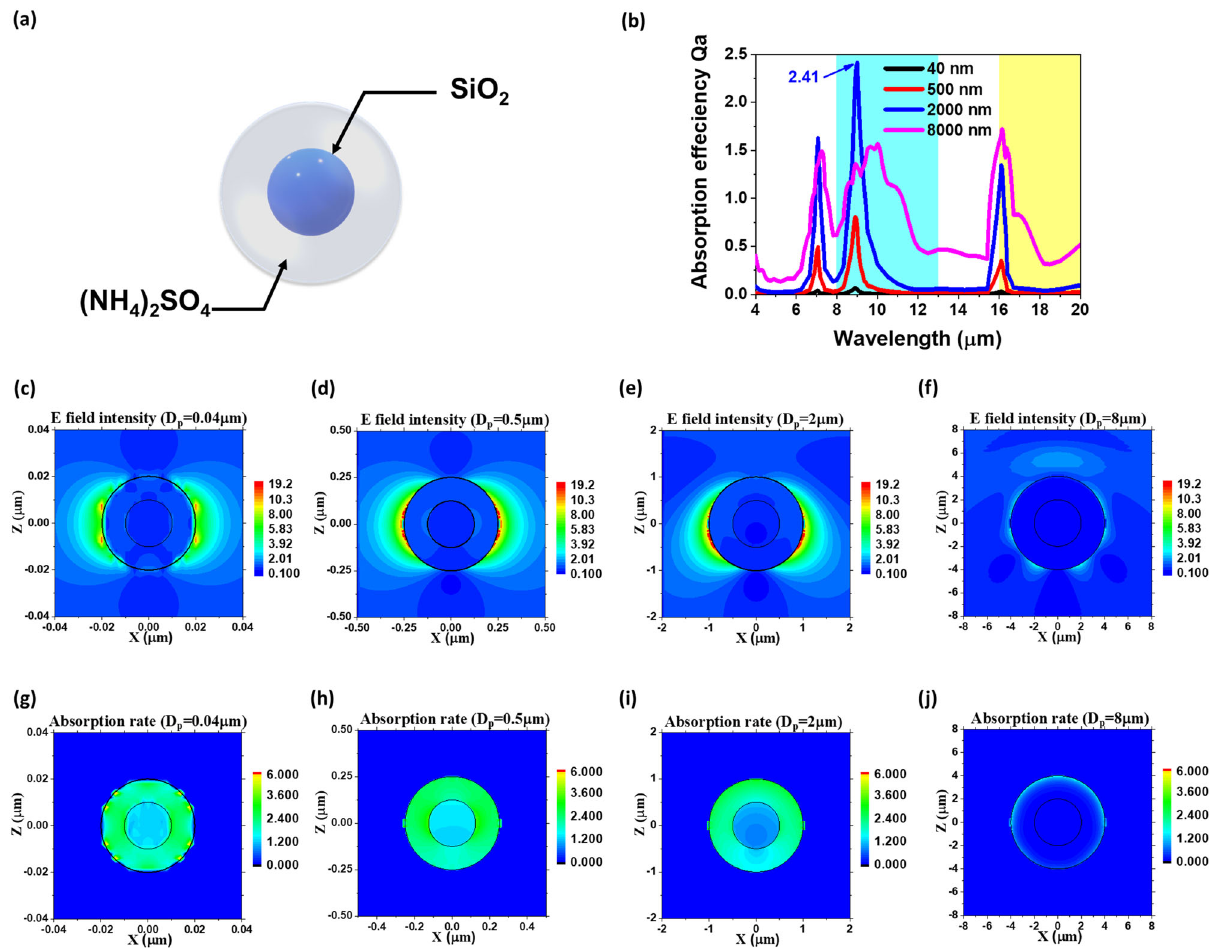
Fig. 3 The Q a spectra and simulated E- fi eld intensities and absorption rates of 0.04, 0.5, 2, and 8 µ m core/shell structure particles. a Schematic representation of the core/shell structure, with SiO 2 as the core surrounded by a concentric spherical shell of (NH 4 ) 2 SO 4 . Here, the core/shell ratio is set at 0.5. b Q a spectra of core/shell structures having values of D p of 0.04, 0.5, 2, and 8 µ m. c – f Simulated E- fi eld intensities and g – j simulated absorption rates of c , g 0.04-, d , h 0.5-, e , i 2-, and f , j 8- µ m core/shell structure